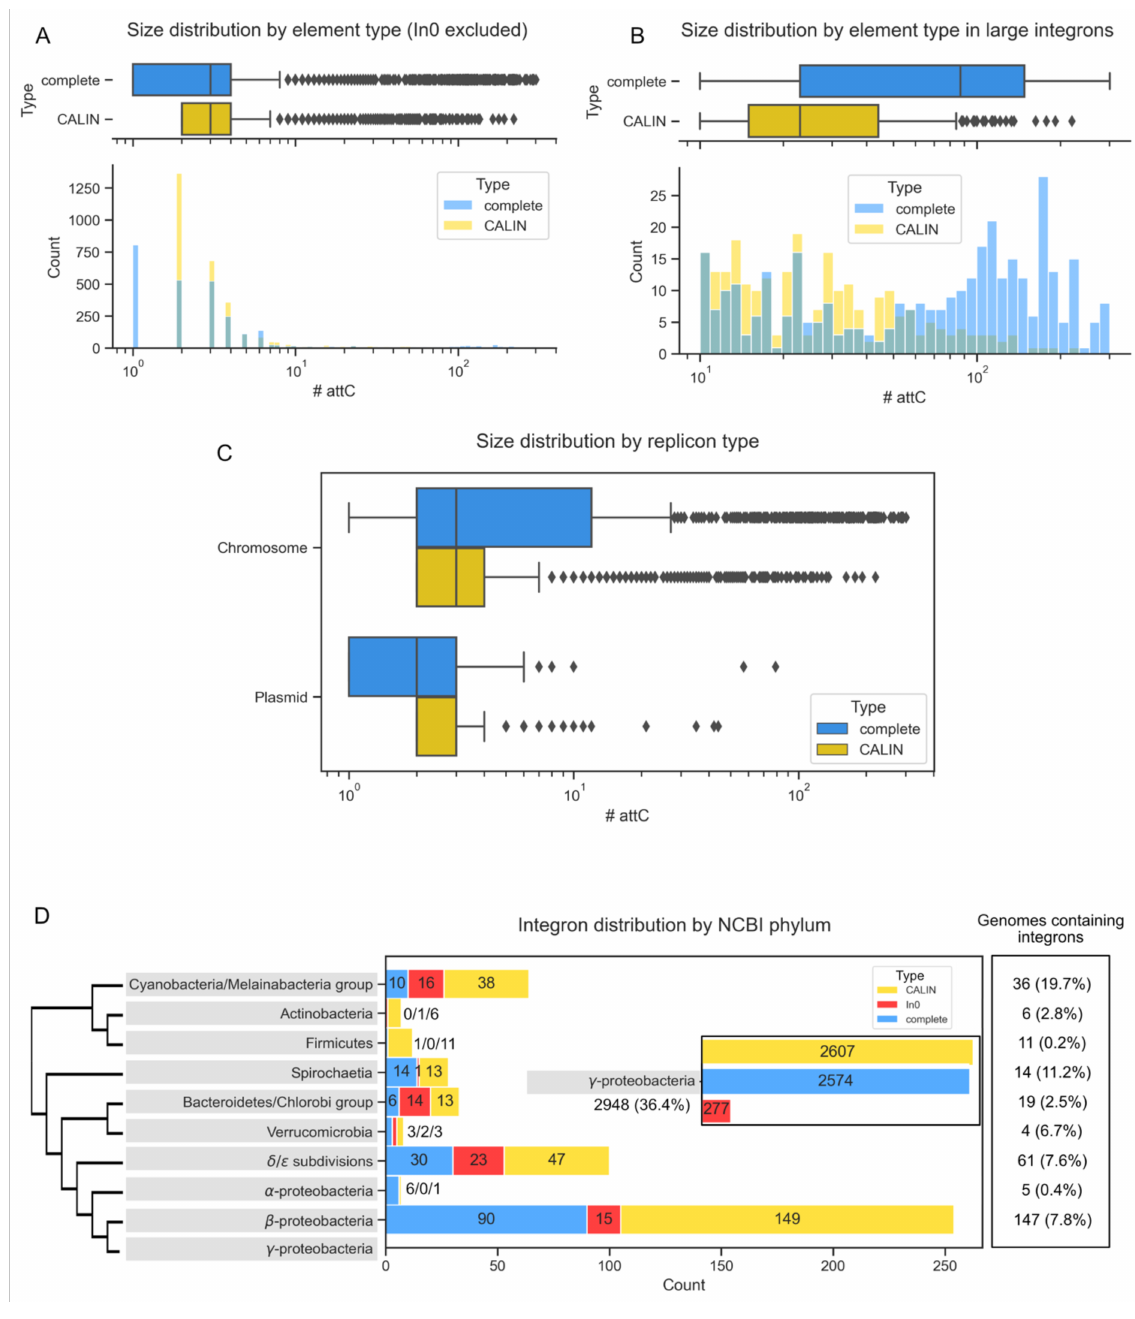
Figure 2. Statistics concerning the distribution of integrons in the RefSeq NCBI database. Distribution of the number of attC sites found per element (complete integron or CALIN) ( A ) and zoom on the distribution of large elements (>10 sites, B ). Distribution of number of attC sites per type of integron and replicon ( C ). Distribution of integrons across major bacterial phyla. Only phyla comprising integrons are shown. The percentage in the last box is the proportion of the genomes in our database that contain at least one integron ( D